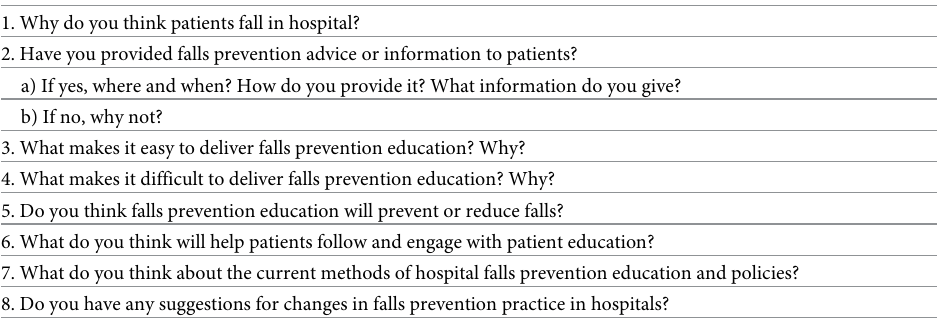
Table 1. Interview question guide for focus